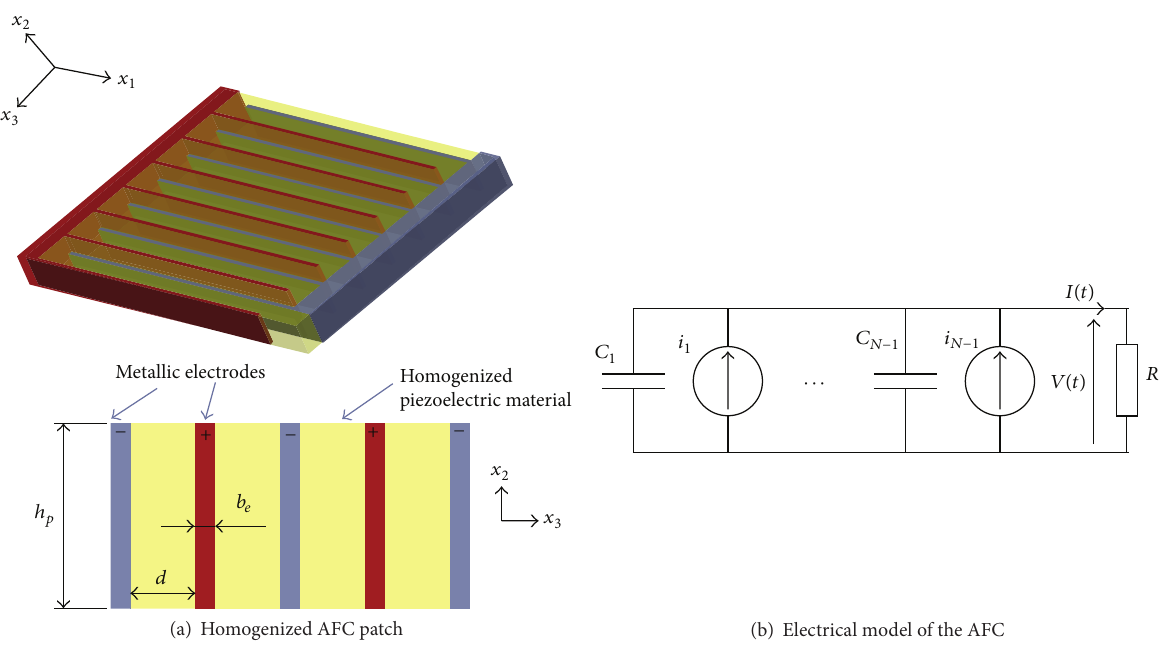
Figure 5: Modeling of the AFC